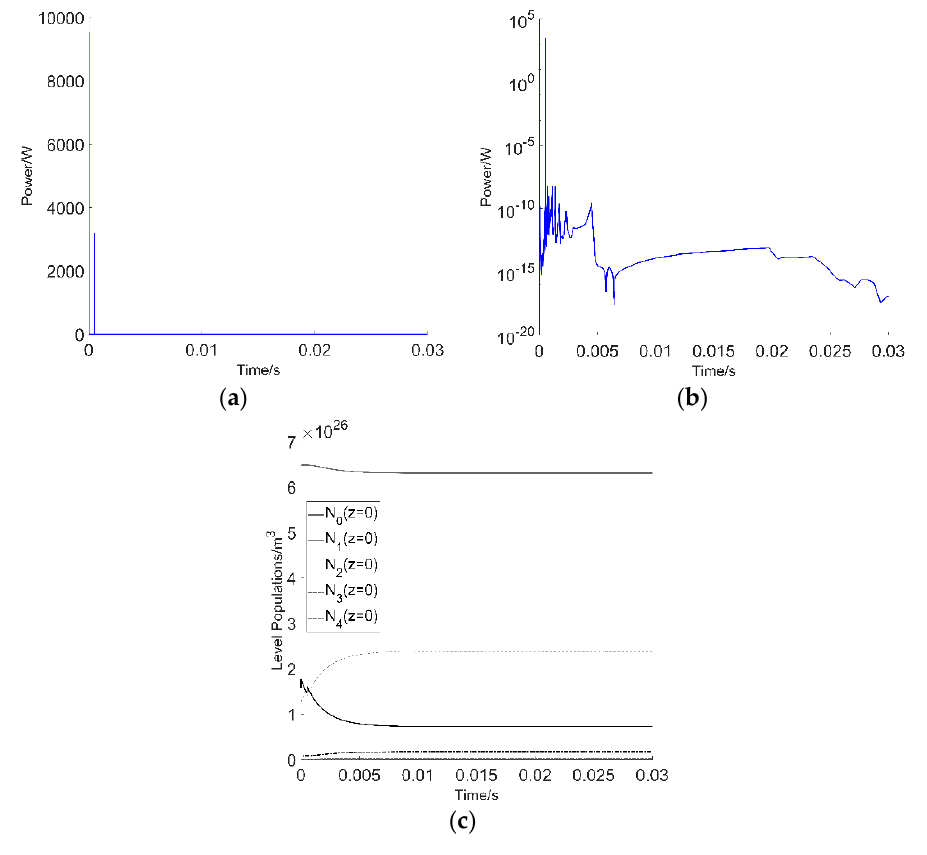
Figure 13. Numerically calculated dependence of the output power and energy level populations on time for 5 pulses at T tr = 200 (ns) with the facet reflectivity for signal wave at z = L switched between 0.04 and 0.2, L = 2 (m) and pump power of 8 (W): ( a ) Output power on linear scale; ( b ) Output power with vertical logarithmic scale; ( c ) energy level populations. In these simulations the spontaneous emission coefficient γ sp (Equation (1)) was assumed equal to zero.